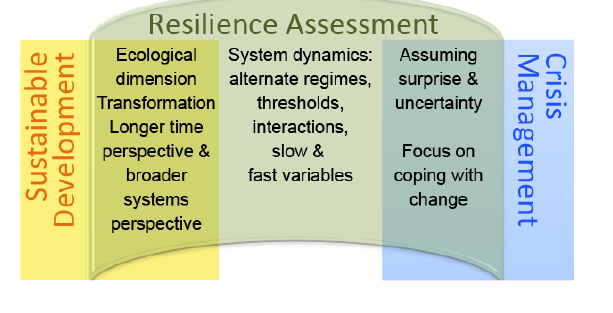
Fig. 5 . Bridging sustainable development and